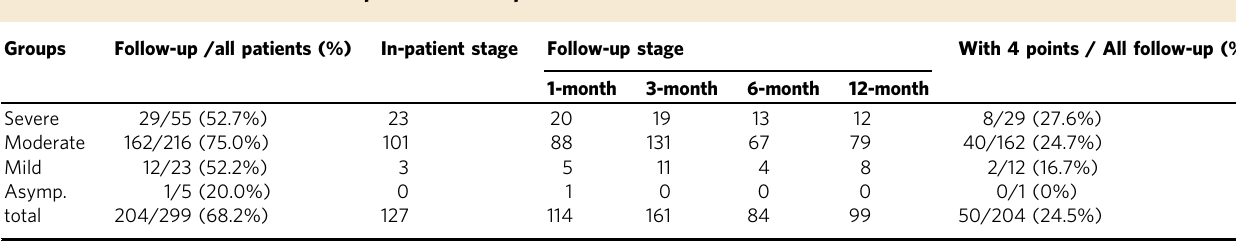
Table 1 Basic information of follow-up SARS-CoV-2 patients.